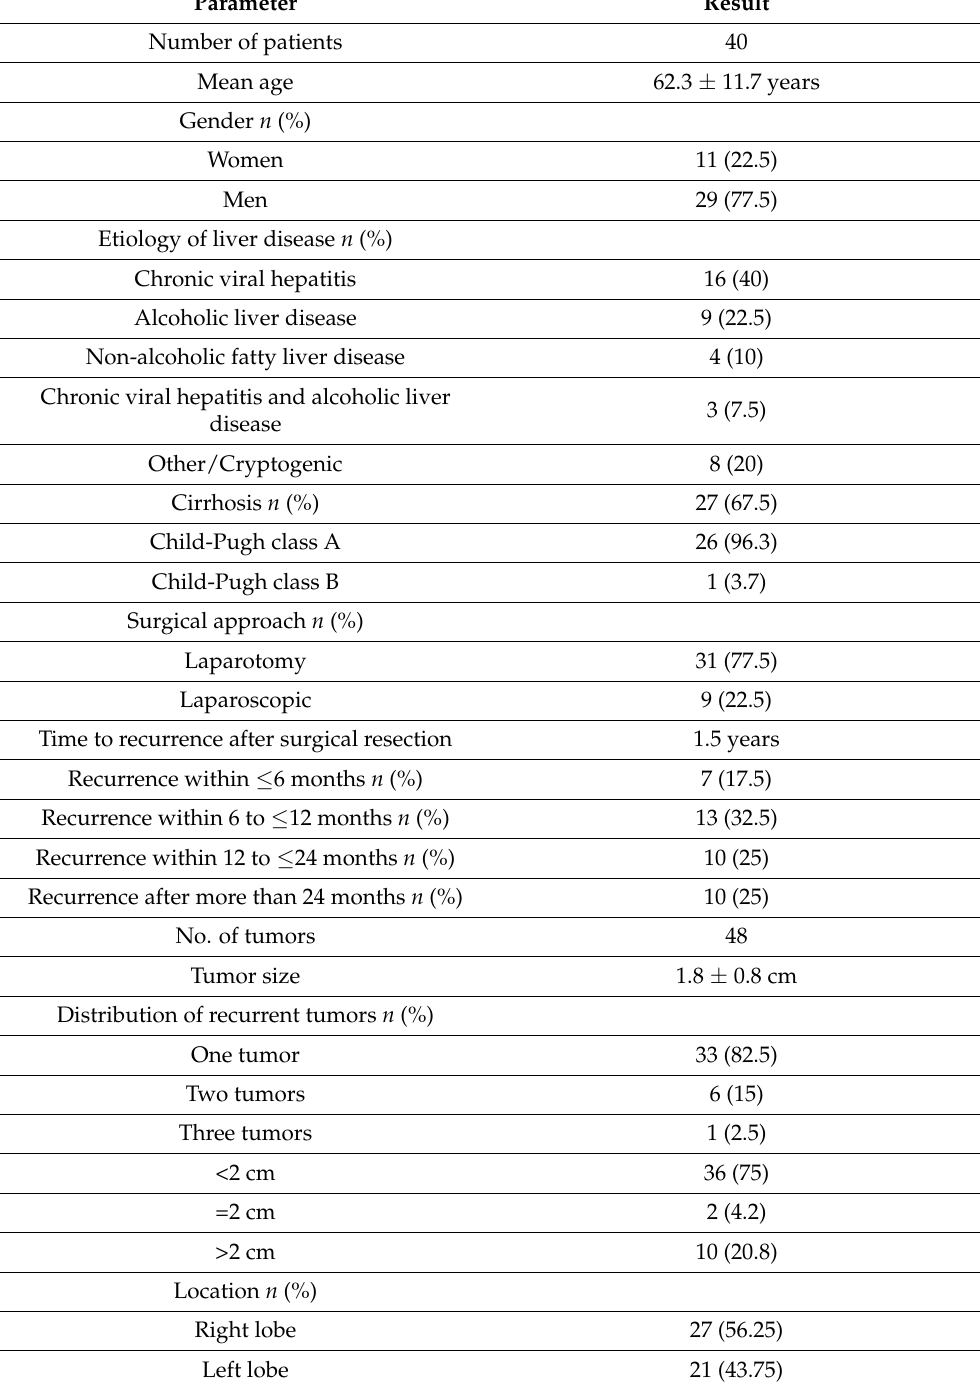
Table 1. Patients’ and tumors’